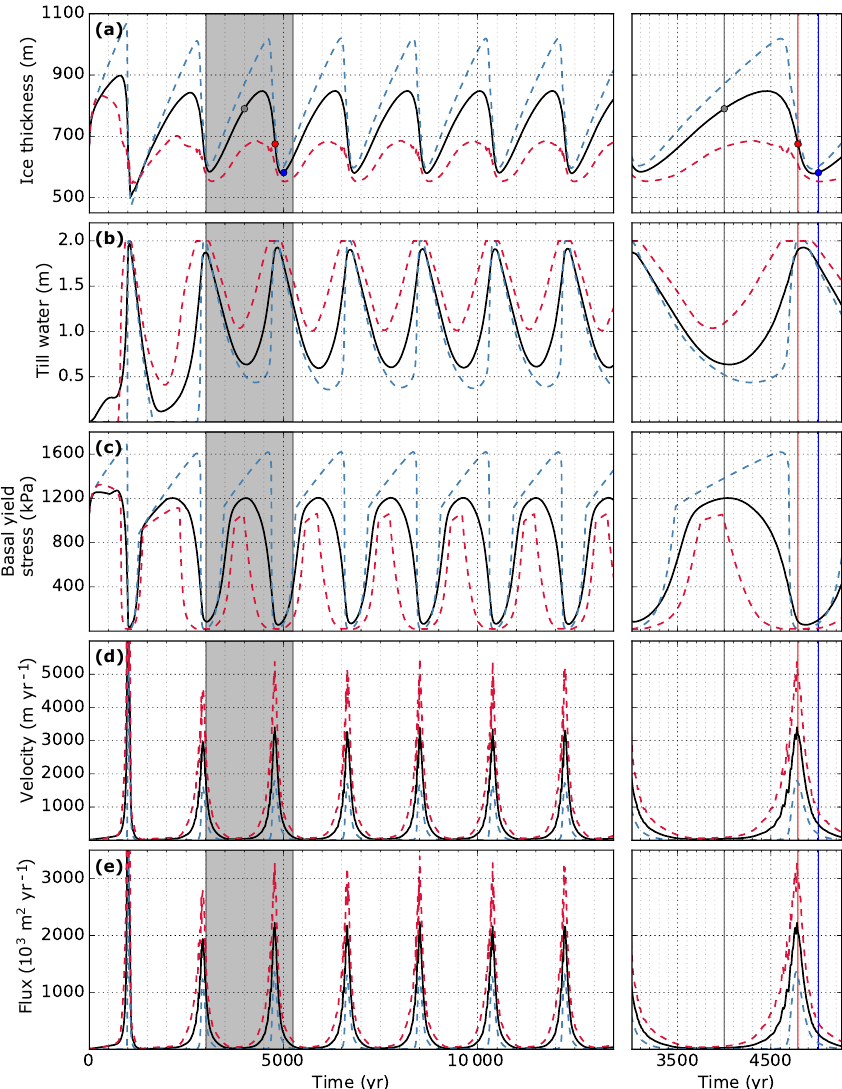
Figure A1. Time series complementing Fig. 3, showing centerline-averaged values (black curve) and two point measurements on the center- line (dashed blue and red curves; locations highlighted by squares in Fig. 1a) instead of grounded-area averaged